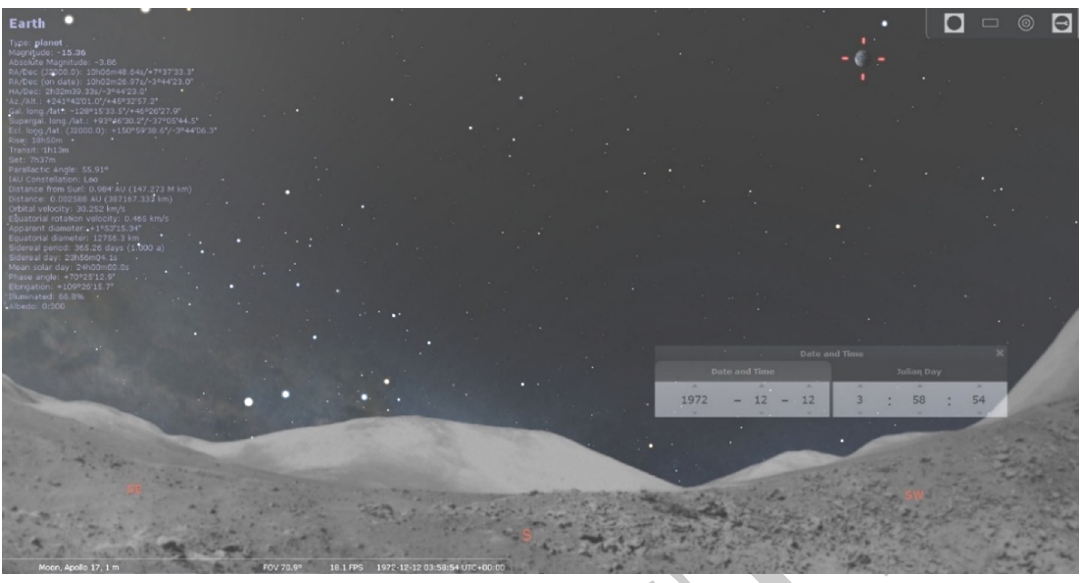
Figure 4. Stellarium software simulation of the view over Apollo 17 landing site showing the Earth at about SW and at an altitude angle of 45°32 ′ 57 ′ ’.